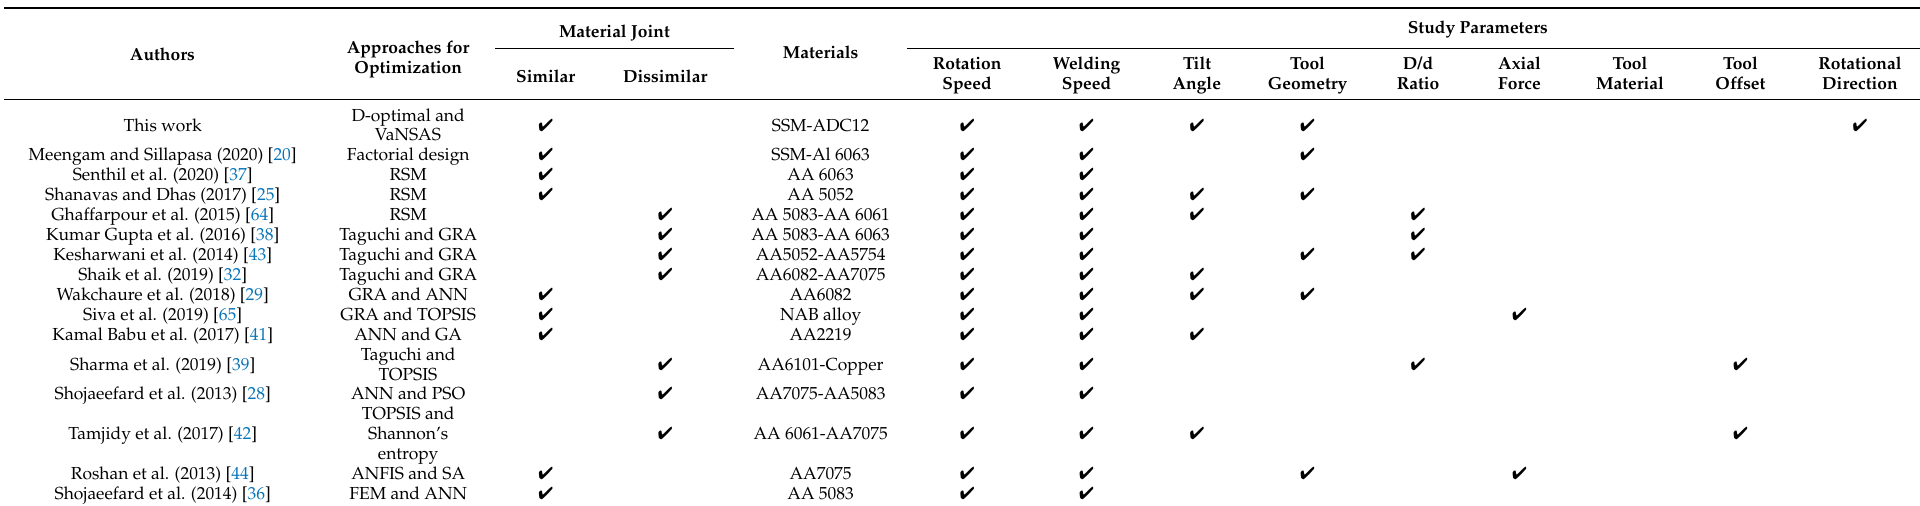
Table 2. Parameters study for optimization from literature